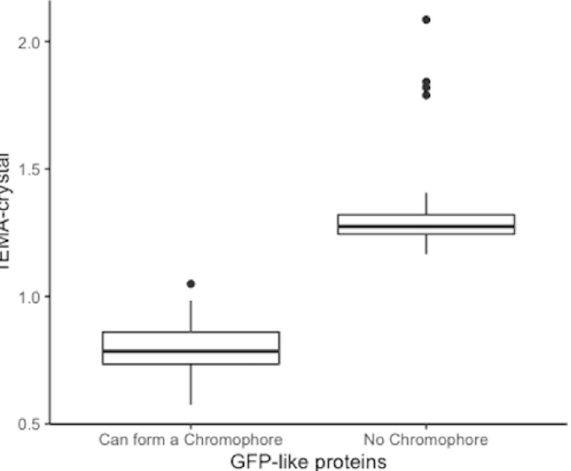
Fig 2. RMSD overlap of the α -helix of the 1EMA-crystal structure with the α -helix of 1EMA as determined by AlphaFold2 for GFP-like proteins that will form a chromophore (SYG) and those that do not (no SYG).